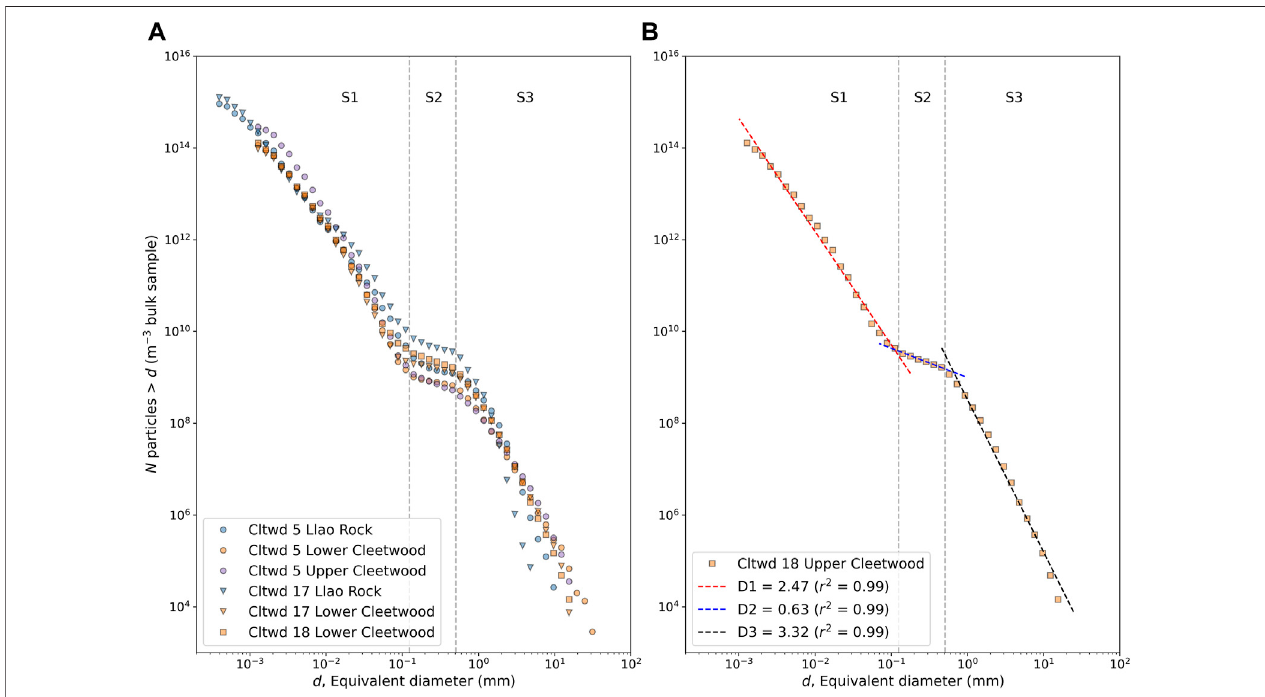
FIGURE6|(A) Cumulativenumberdensity, N ,vsequivalentdiameter, d ,forLlaoRock,lowerCleetwood,andupperCleetwood atCltwd5,LlaoRockandlowerCleetwood at Cltwd17,andlowerCleetwood atCltwd18. (B) Cumulativenumberdensity, N ,vsequivalentdiameter, d ,forlowerCleetwood atCltwd18.Breaksinslopeat~0.125and~0.510 mm create three individual segments S1, S2, and S3, which are observed in all distributions (see A). Fractal dimensions (D1, D2, and D3) are obtained by fi tting each corresponding segment with a power law, N > d = λ d − D , where N is the number density of particles greater than size d , D is the fractal dimension, and λ is a scaling factor.